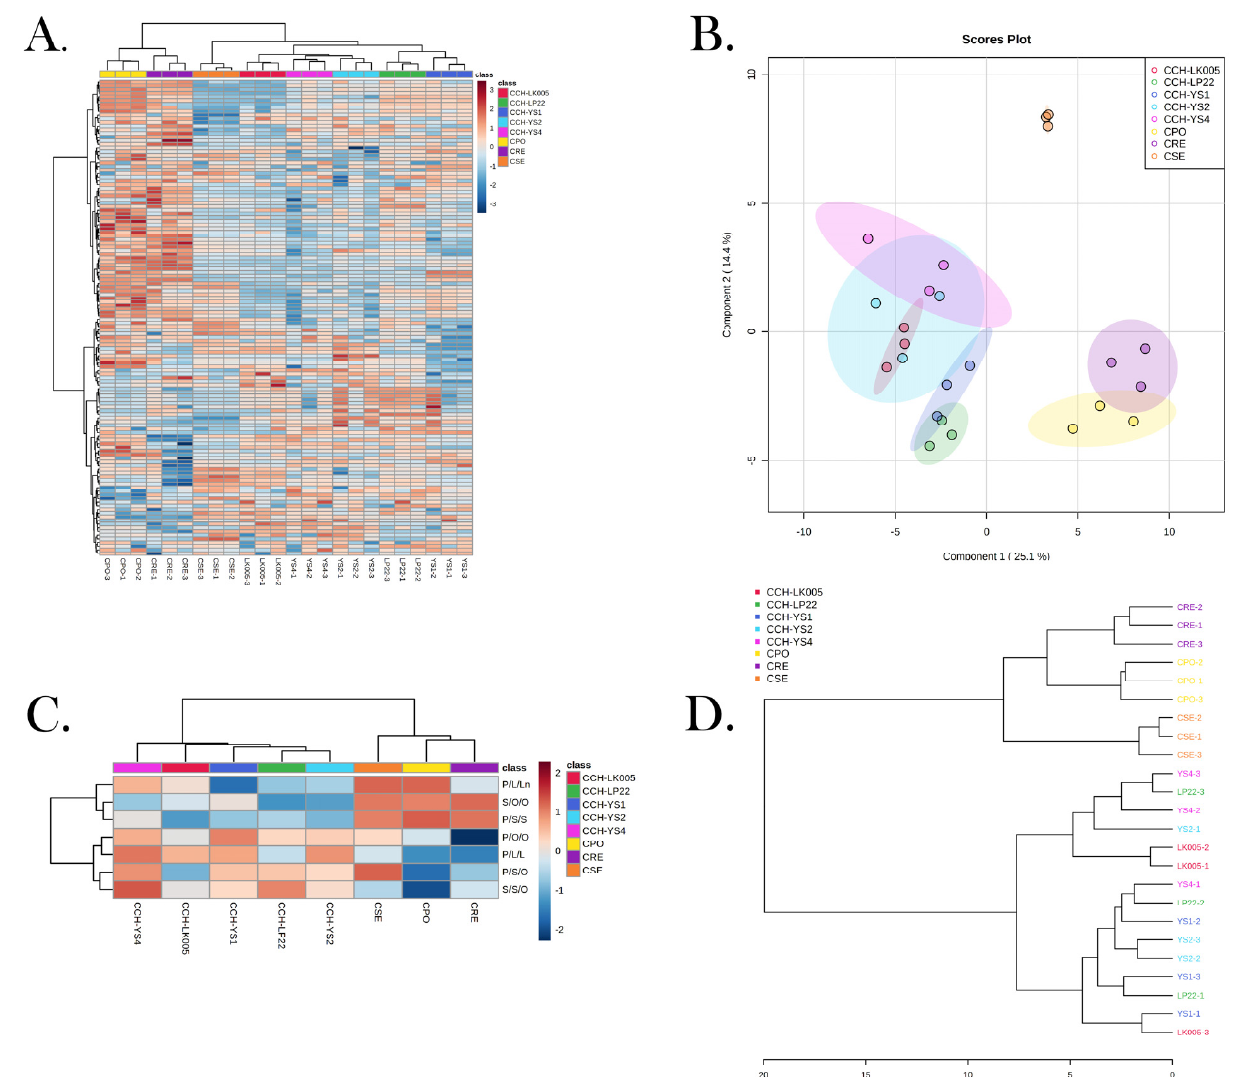
Figure 3. ( A , B ). Heatmap and PLSDA model diagram based on relative triglyceride content; ( C , D ). heatmap and dendrogram based on relative contents of characteristic triglycerides. YS-1, YS-2, YS-4, LK005 and LP22 all represent clone varieties of ROC , and CPO , CSE and CRE fruit materials were mixed samples of 5 clones.